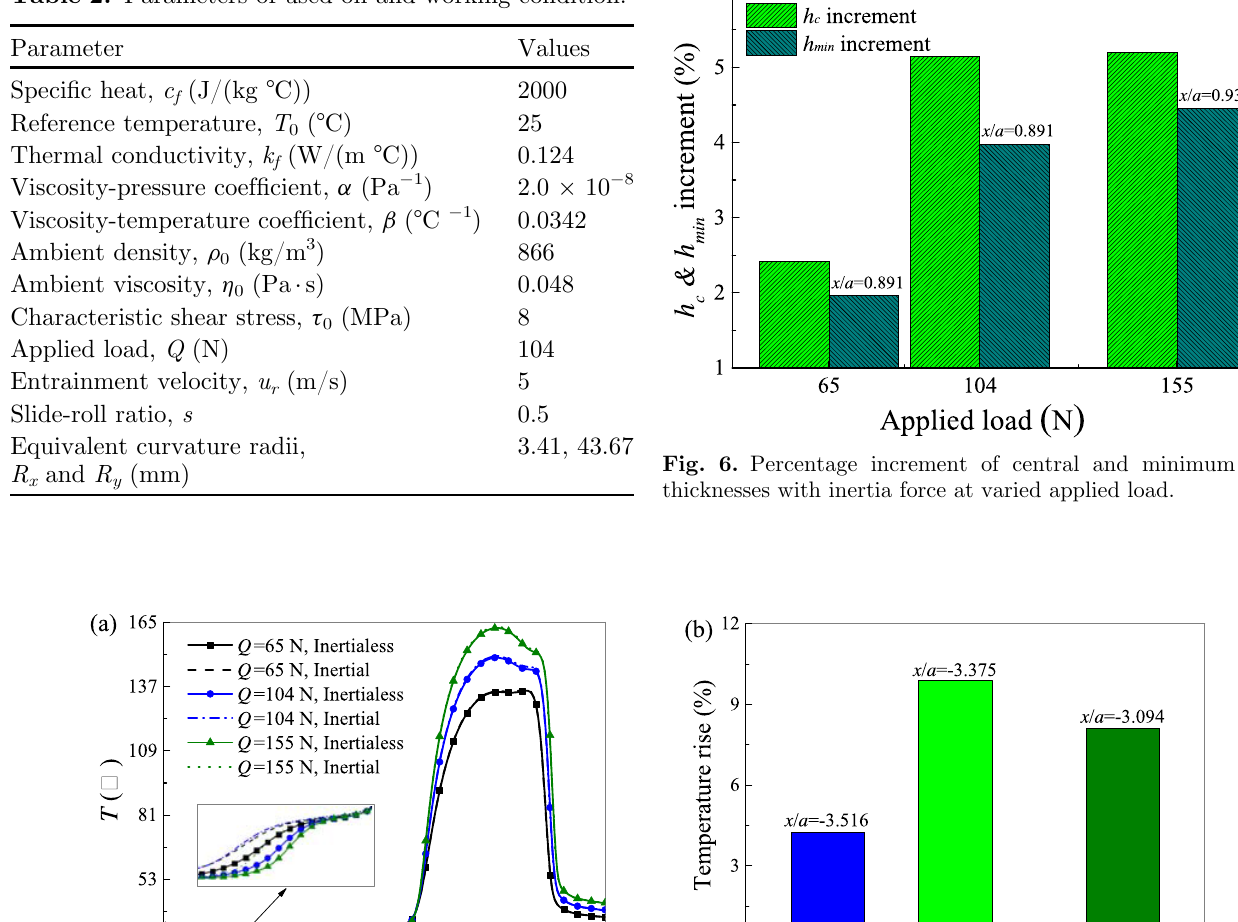
Table 2. Parameters of used oil and working condition.